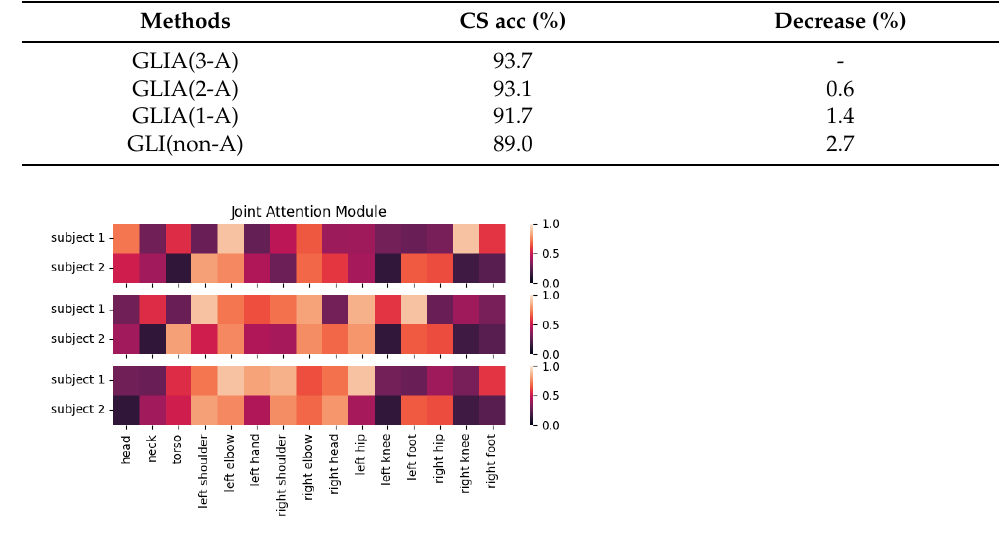
Figure 7. Attention visualization for the handshake action, where the top ones corresponds to the shallow layer of the network. The attention weights are normalized.